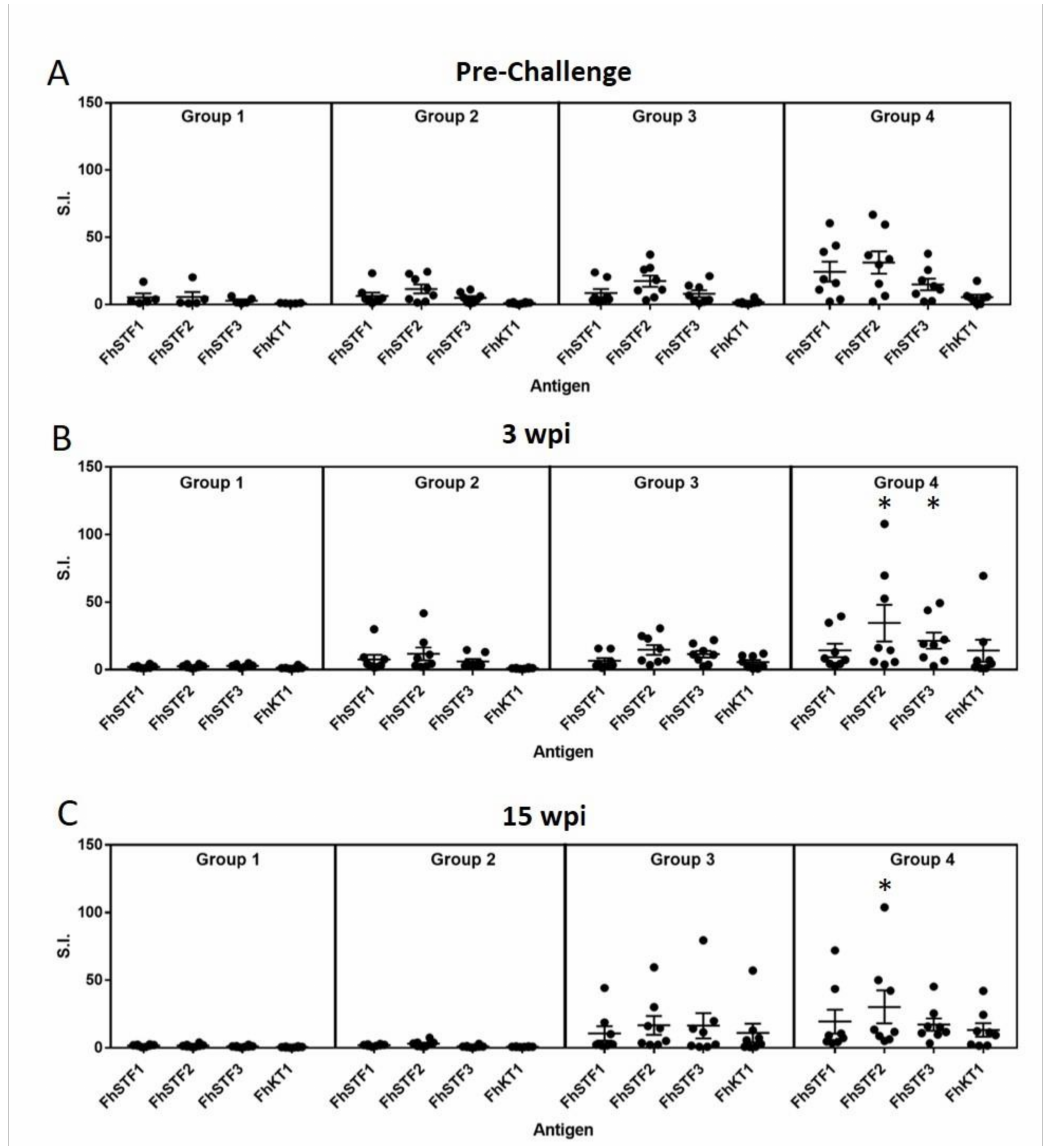
Figure 5. Proliferative responses of PBMC stimulated with the recombinant stefins and Kunitz-type antigens. PBMC were analysed at three time points, namely ( A ) prior to infection with F. hepatica metacercariae (pre-challenge), ( B ) 3 wpi and ( C ) 15 wpi. Proliferation is expressed as Stimulation Index (S.I.). Group 1, control unvaccinated, uninfected; Group 2, control unvaccinated, infected; Group 3 and Group 4, vaccinated, infected. * p < 0.05 relative to the values obtained from the non-vaccinated, non-infected group (G1) at the respective